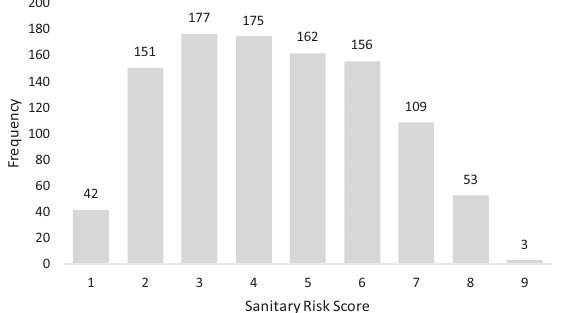
Fig. 1 Frequency of sanitary risk scores at 1028 handpumps with boreholes in sub-Saharan Africa. The frequency of sanitary risks scores shows that 2-7 sanitary risk factors were identi fi ed at most handpumps and zero received a risk score of 10, which indicates the highest levels of sanitary risk.